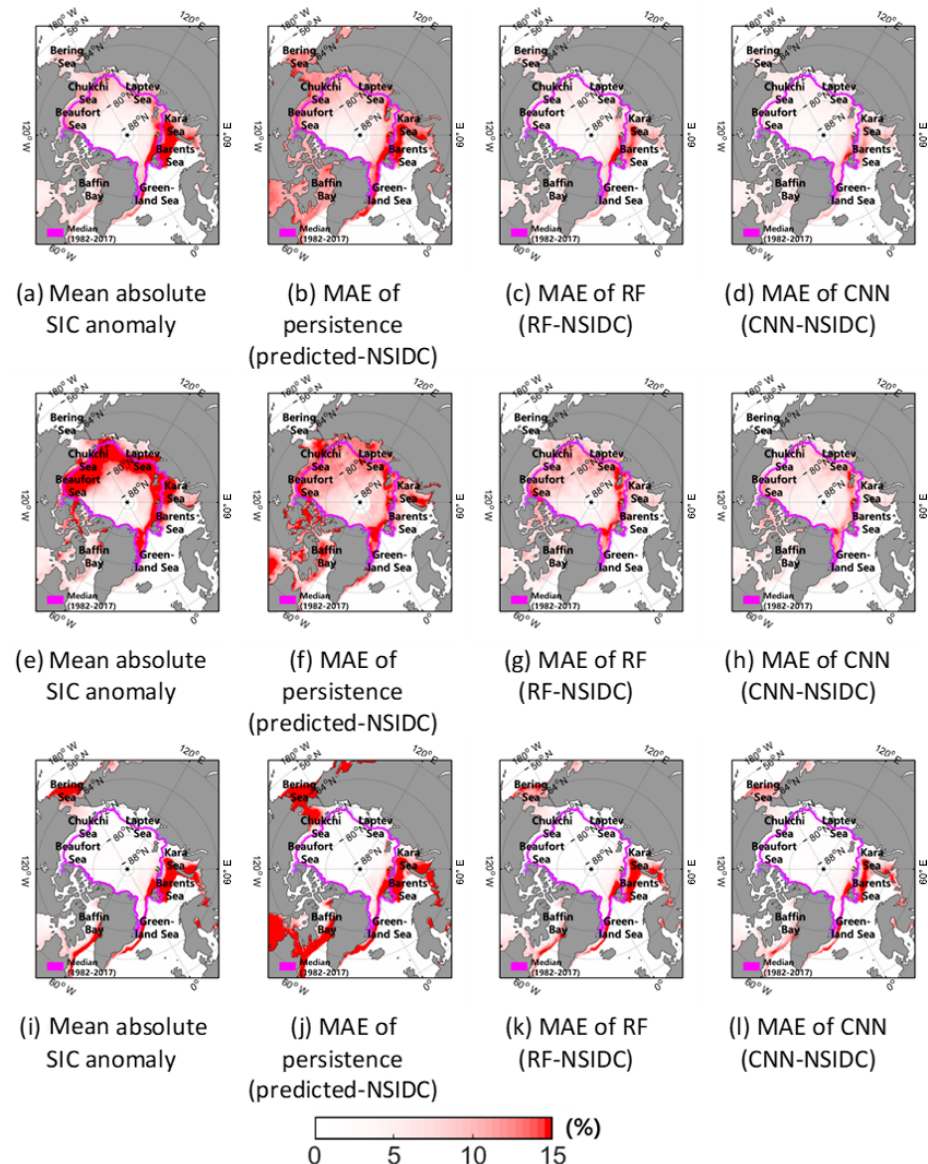
Figure 2. The mean absolute SIC anomaly (a) and mean absolute errors between predicted SICs and the actual SICs by the persistence (b) , RF (c) , and CNN (d) during 2000–2017. As in (a–d) but for the melting (June–September) and freezing (December–March) seasons, shown in (e–f) and (i–l) ,